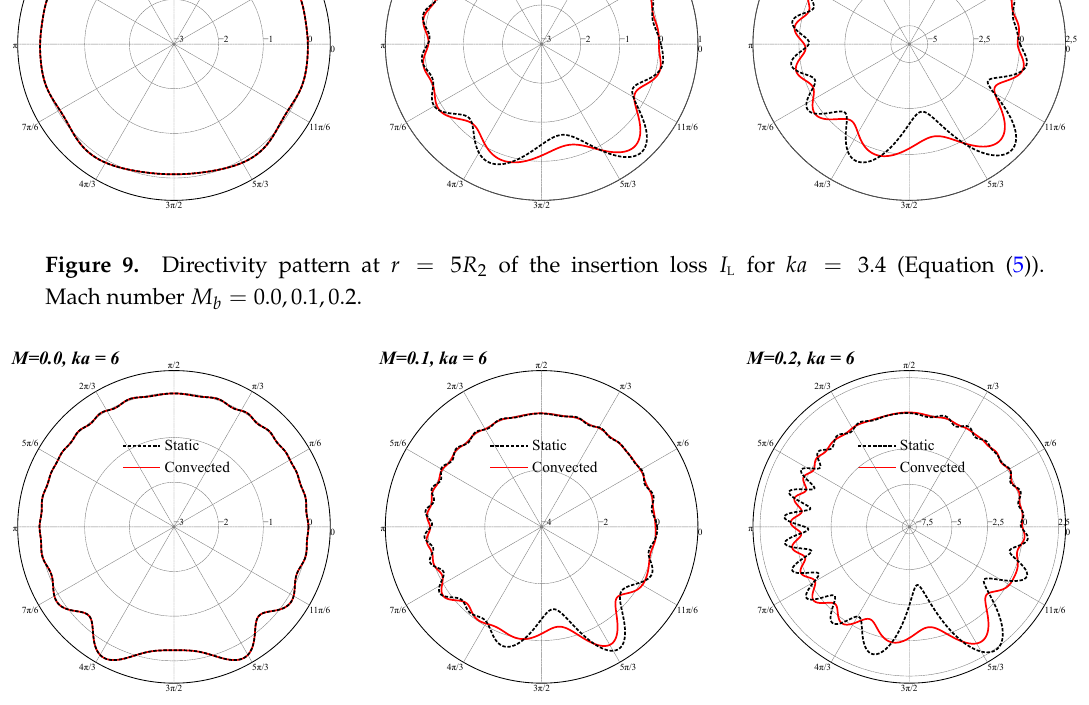
for ka = 6 (Equation (5)). Mach number L